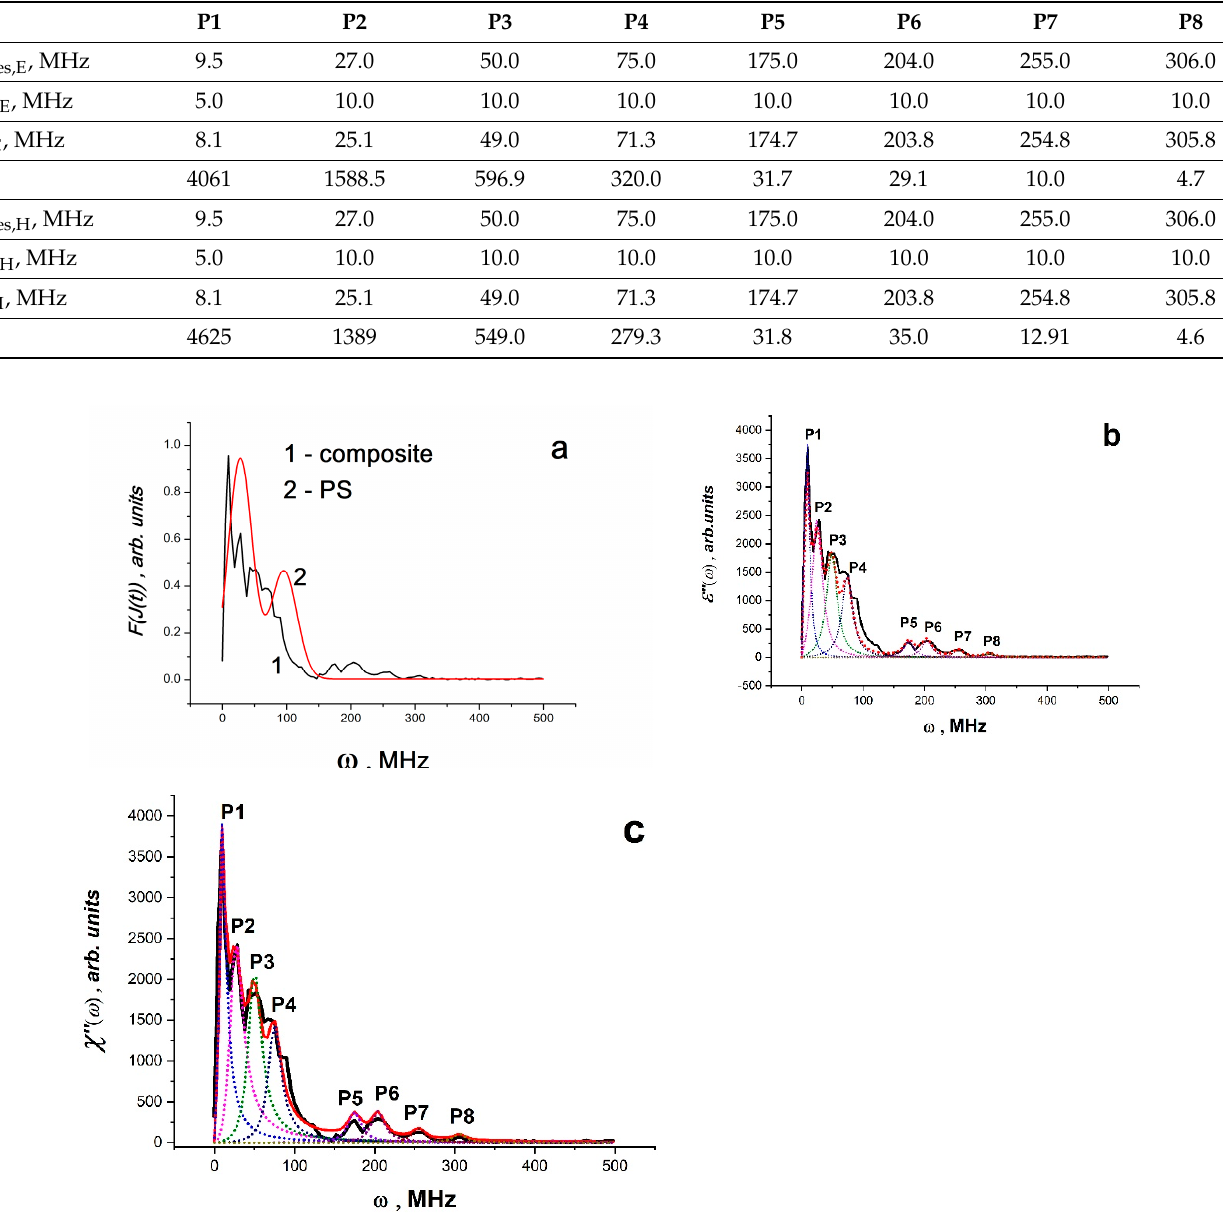
Figure 10. ( a ) normalized Fourier image of the electrical signal for the composite K5 (1) and PS (2). ( b ) Fourier image of the electrical signal for the composite K5 and the radiation bands obtained by the Lorentz method (their parameters are given in Table 1). ( c ) Fourier image of the electrical signal for the composite K5 and the bands the radiations obtained by the Landau–Bloch–Blombergen method (their parameters are given in Table 3) (From [48] with permission). Table 3. Parameters of the radiation bands.